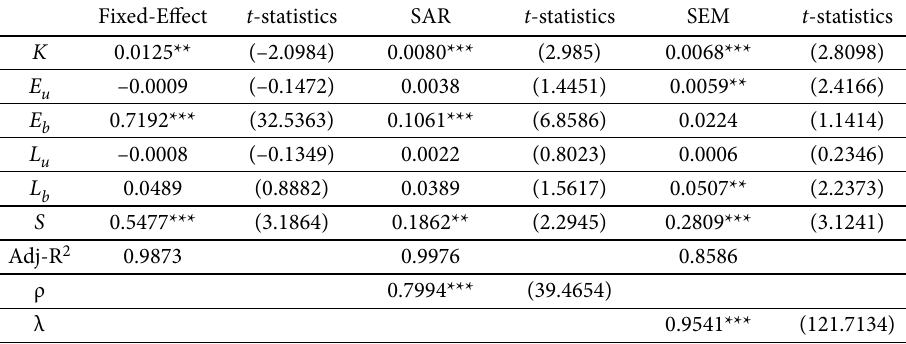
Table 4. Full sample estimation of educational impacts in spatial panel